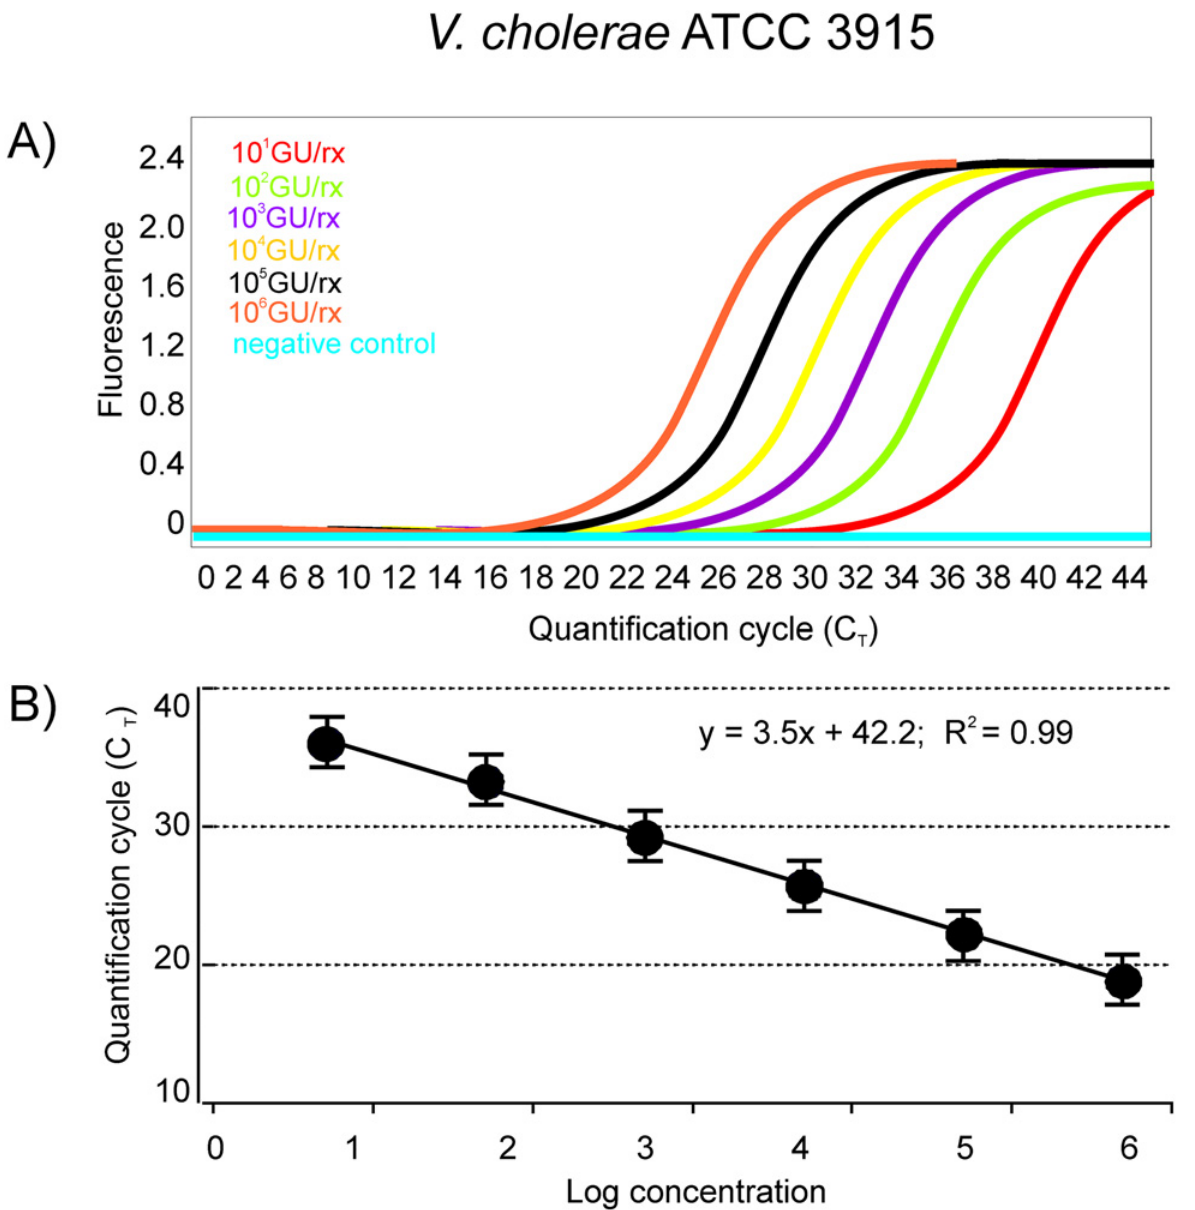
Fig 1. Sensitivity of the qPCR assay for detection of V . cholerae O1 El Tor N16961. DNA was amplified with the gbpA TaqMan primers in the presence of the gbpA fluorogenic probe. (A) Amplification plot of V . cholerae ATCC 39315 sample dilutions containing 10 6 , 10 5 , 10 4 , 10 3 , 10 2 , 10 1 genome copies per reaction (GU/rx). (B) Plot of mean Cq-values from three replicates tested against the V . cholerae DNA inputs. Error bars indicate the standard deviations of the